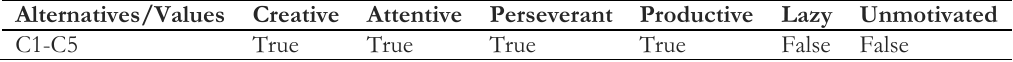
Table 8. Criteria matrix.